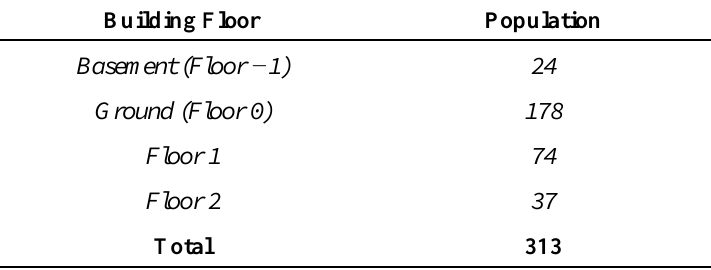
Table 1. Aggregated population distribution for the different building floors.